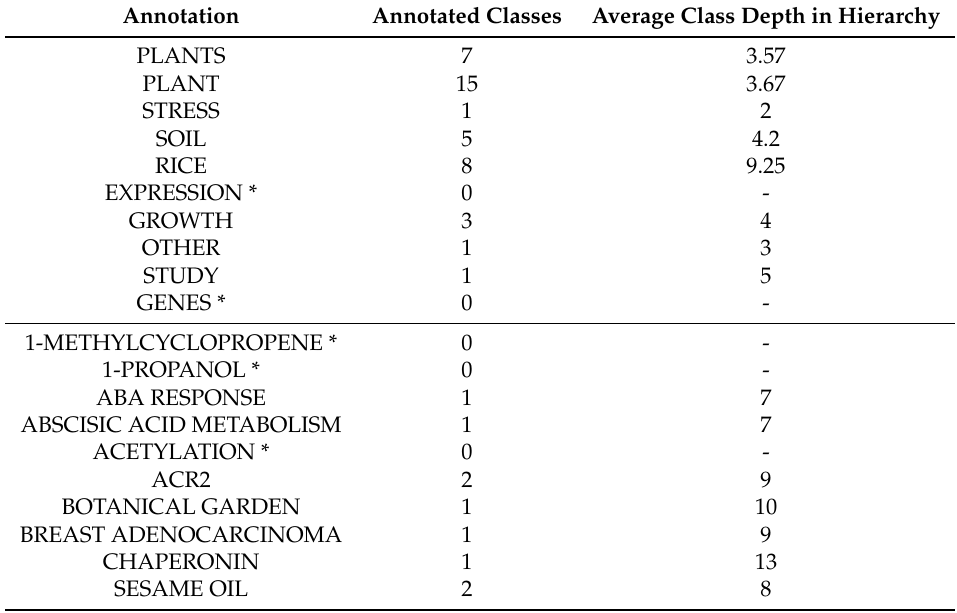
Table 3. Common and unique annotations together with the number of ontology classes supporting them and the average depth of these classes in their ontology. Annotations marked with * are linked with individuals and not with classes, thus, average class depth could not be calculated.